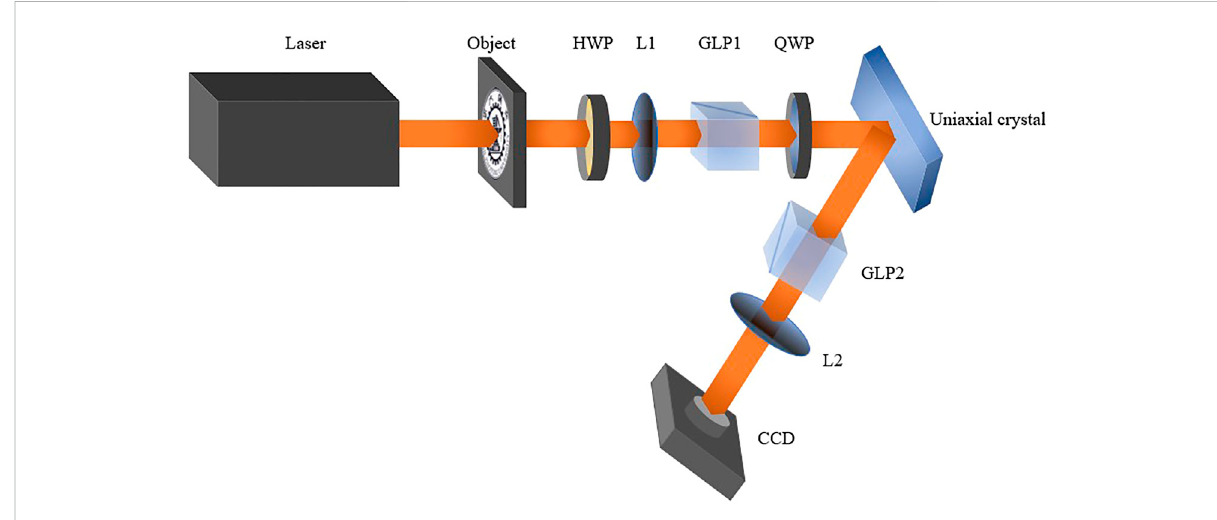
FIGURE 3 Optical setups for spatial differentiation based on